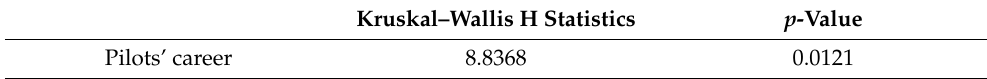
Table 9. Nonparametric test.